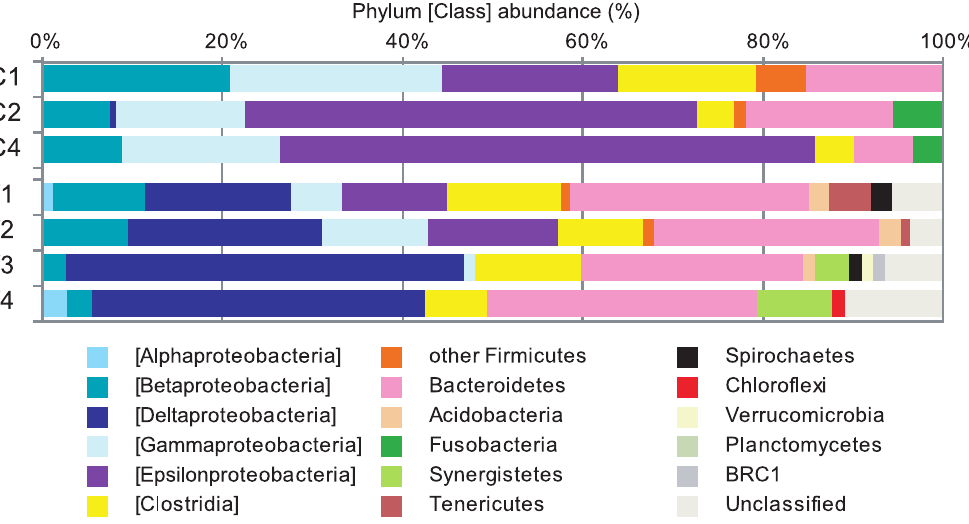
Figure 6. Phylum level taxonomic distribution of 16 S rRNA community profile. The taxonomic profiles were analyzed for the original primary clarifier effluents (PC1, PC2, PC4) and the MFC anode biofilms (W1–W4). Phylum Proteobacteria and Firmicutes are divided into class